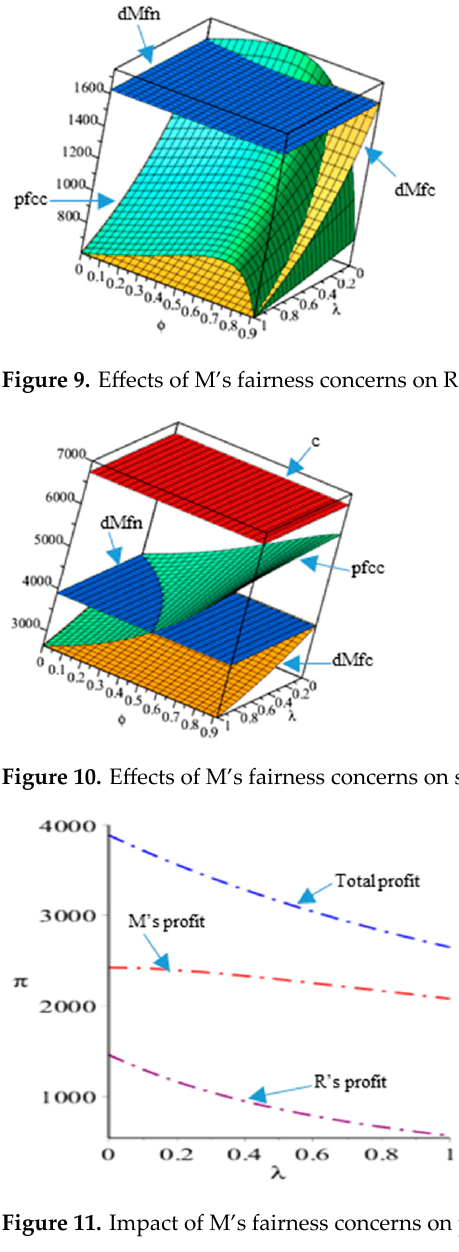
Figure 8. Effects of M’s fairness concerns on M’s profits.